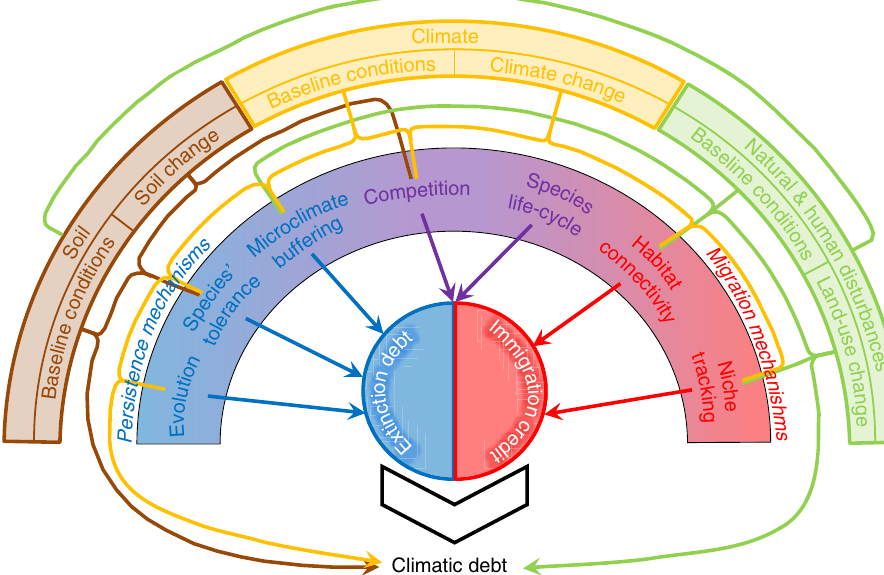
Figure 1 | Conceptual framework of the climatic debt determinism. The climatic debt is an integrative measure of the lag in the reorganization of plant communities driven by climate change, but also by the environmental context (that is, baseline conditions and magnitude of change) that interferes with this response. These environmental factors can have an impact on plant communities either directly or indirectly, through biotic mechanisms involved in species’ persistence and species’ migration, leading to an extinction debt and an immigration credit, respectively, thereby modulating the climatic debt. NATURE COMMUNICATIONS|7:12643|DOI: